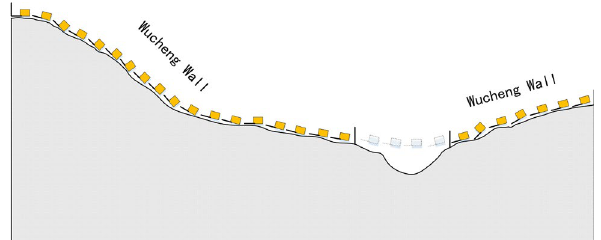
Figure 5. Profile of City